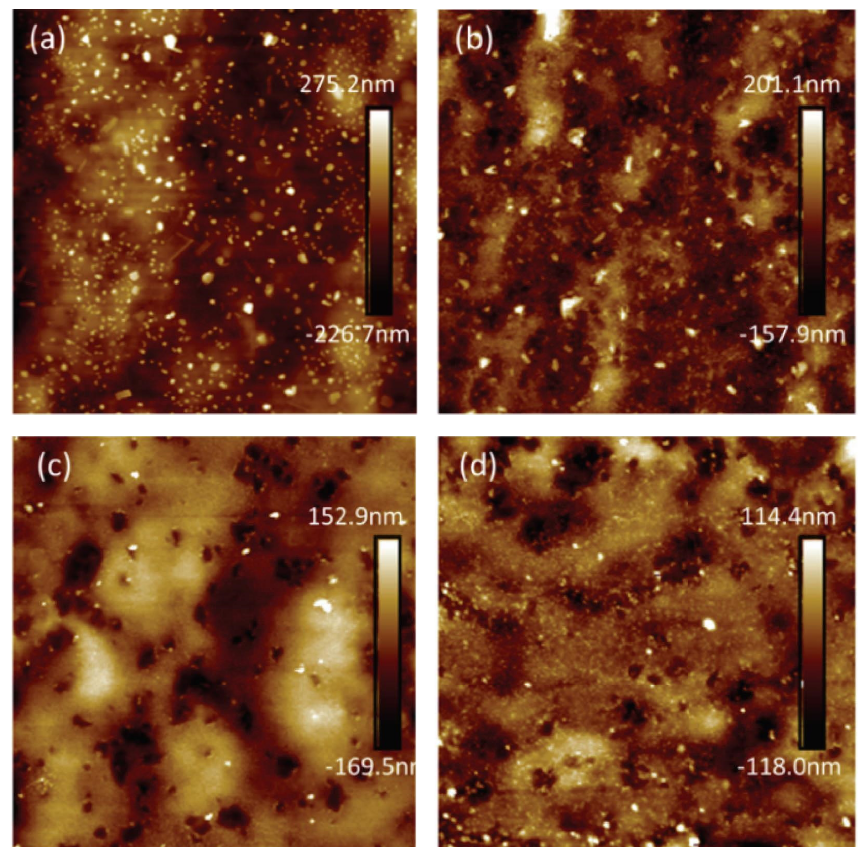
Figure 11: AFM images of 70# asphalt. (a) 76.25h. (b) 152.5h. (c) 228h. (d)